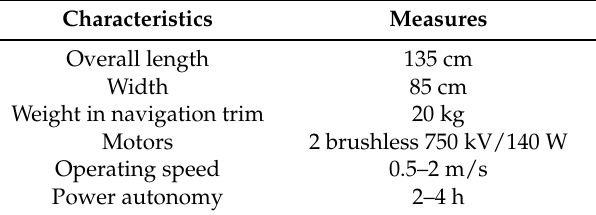
Table 1. Technical and physical characteristics of the drone.